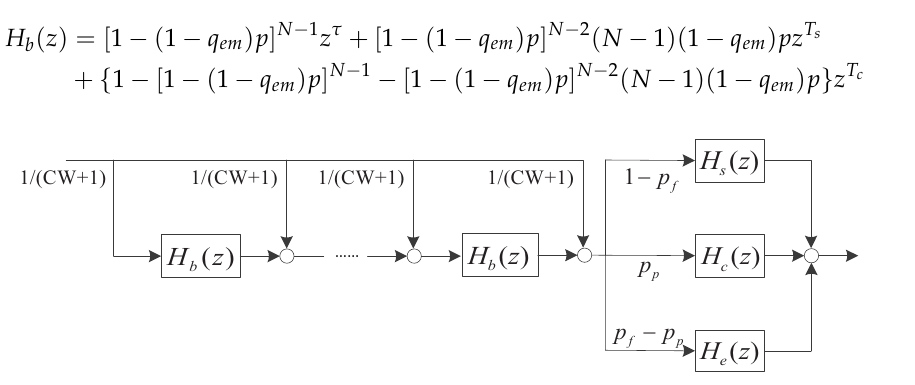
Figure 3. MAC service time linear system